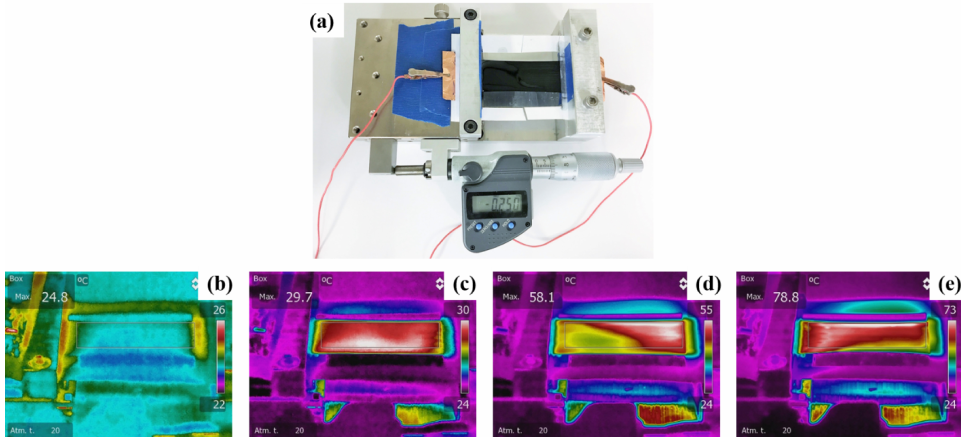
Figure 2. ( a ) CNT sheet connected to copper electrodes on a custom stretching device. Infrared (IR) images of ( b ) a pristine CNT sheet, ( c ) CNT sheet after introduction of polymer in N -methyl-2- pyrrolidone (NMP), ( d ) CNT sheet during initial heating and infiltration of polymer and ( e ) CNT